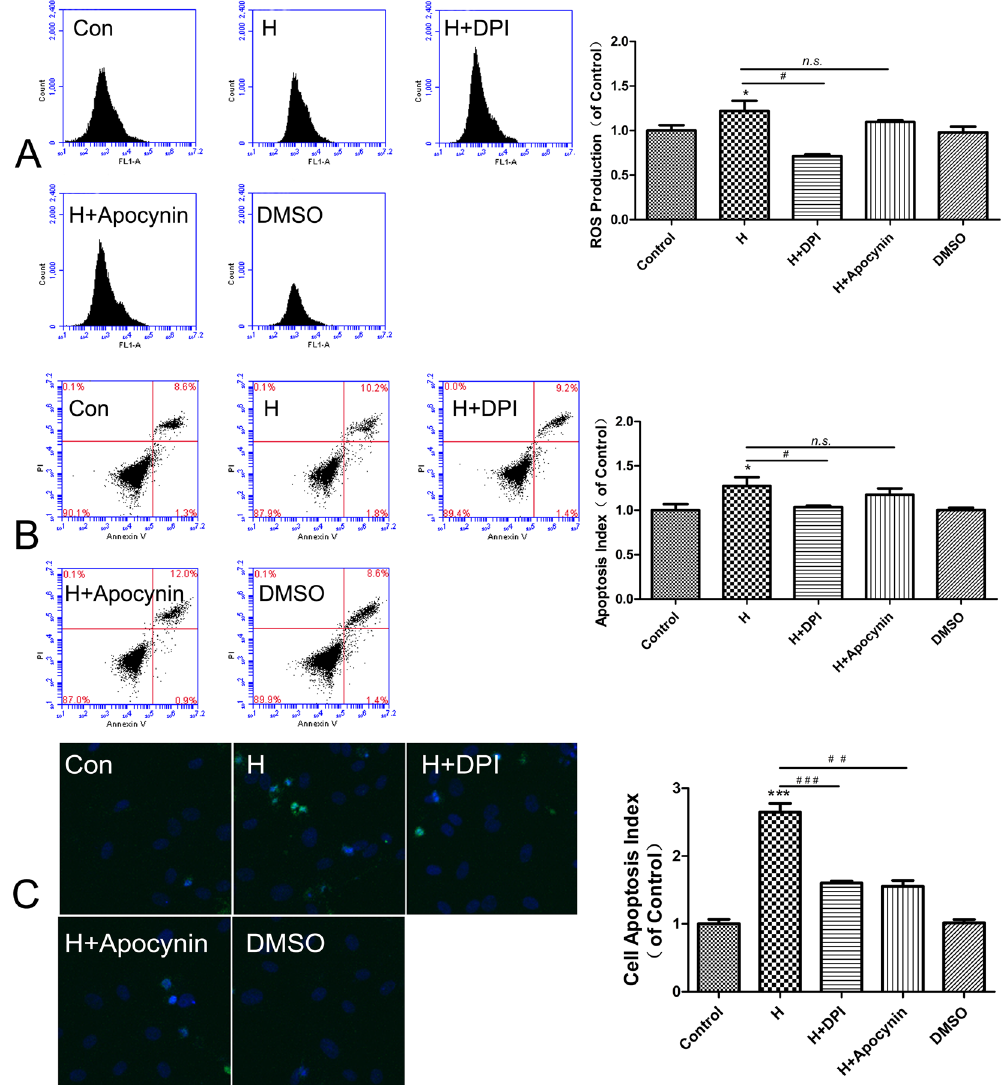
Figure 4. DPI and Apocynin pretreatment attenuated ROS generation and apoptosis in HUVECs induced by 33 mmol/L glucose for 48 h. DPI and Apocynin decreased ROS production in HUVECs induced by high glucose ( A ). DPI and Apocynin decreased the apoptosis rate in HUVECs induced by high glucose, as detected using an Annexin V-PI assay ( B ). DPI and Apocynin decreased the apoptosis rate in HUVECs induced by high glucose, as detected by TUNEL ( C ). Data are shown as the mean ± SEM, n = 5 independent experiments. * P < 0.05 vs control, # P < 0.05 vs high glucose, ** P < 0.01 vs control, *** P < 0.001 vs control, ### P < 0.001 vs high glucose, n.s. P > 0.05 vs high